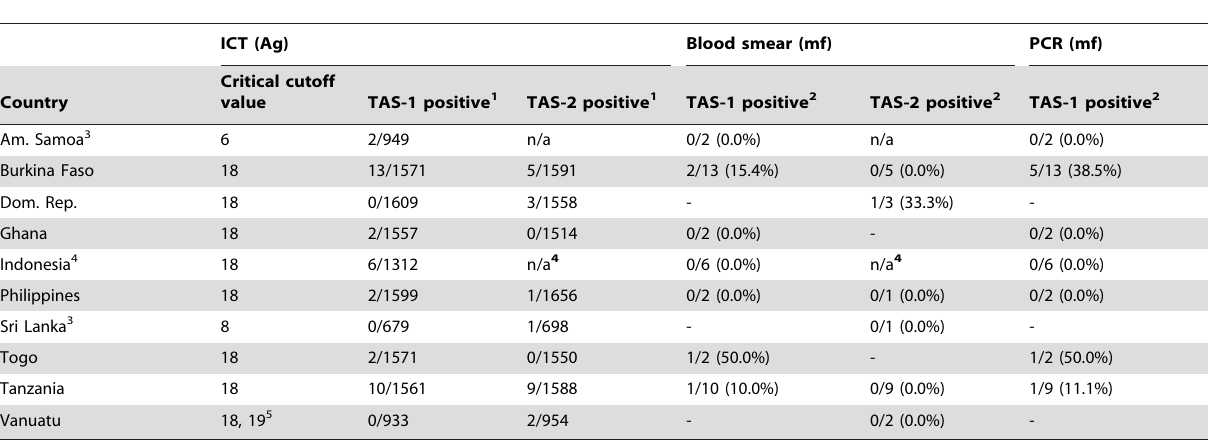
Table 3. ICT, blood smear, and PCR results for W. bancrofti countries.